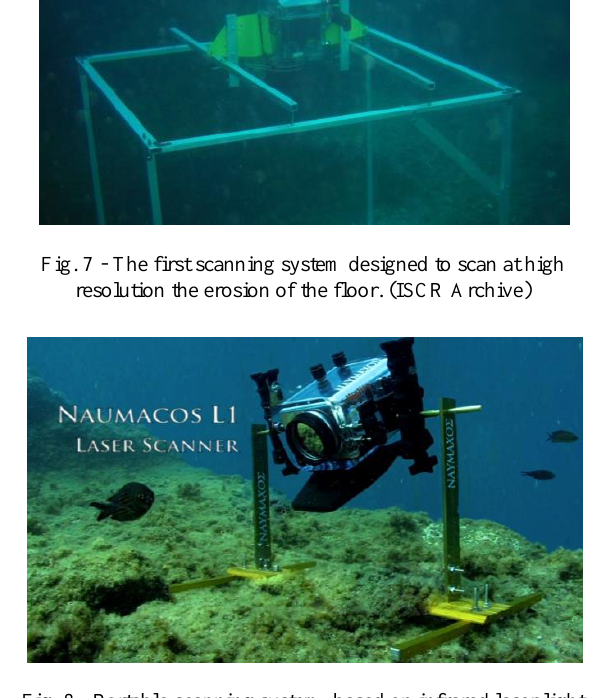
Fig. 8 - Portable scanning system, based on infrared laser light structured. When activated the system begins scanning rotating on its